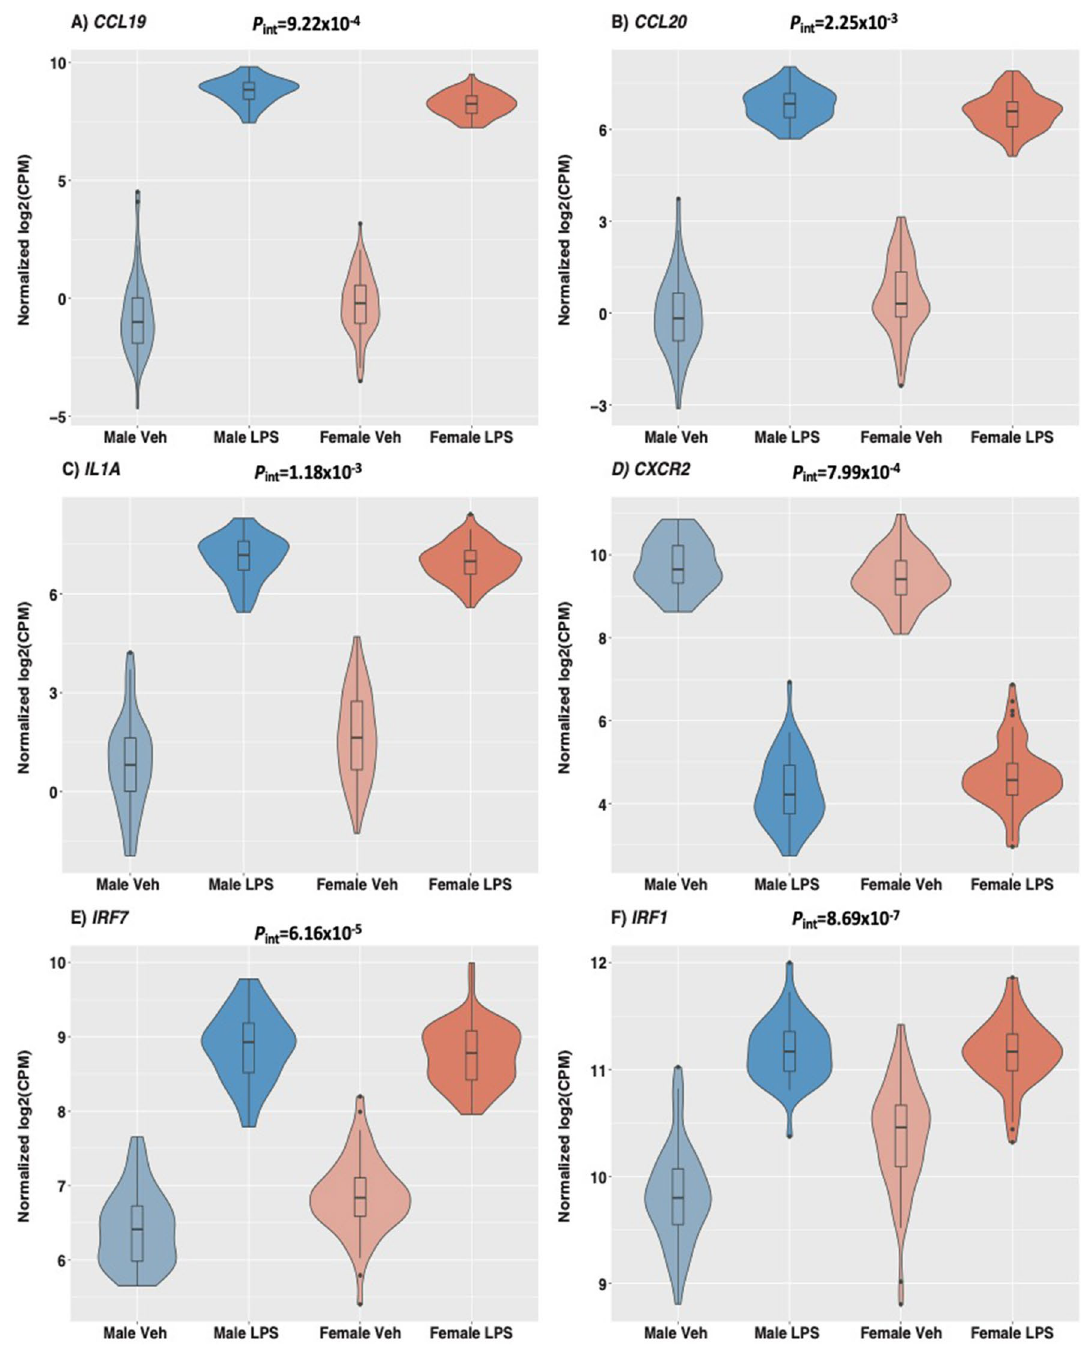
Figure 2. Violin plots of exemplar genes with significant (FDR < 0.05) LPS treatment by sex interaction effects on gene expression indicating different responses to LPS treatment in males and females. Interaction p-values are shown. For each gene, expression levels for each treatment and sex are shown on the x-axis (male untreated, male LPS-treated, female untreated, female LPS-treated). Each boxplot inside the violin shows the 1st-3rd interquartile range; the horizontal line shows the median expression value. ( A ) CCL19 , Chemokine ligand 19; ( B ) CCL20 , chemokine ligand 20/macrophage inflammatory protein-3; ( C ) IL1A , Interleukin 1 alpha; ( D ) CXCR2 , Interleukin 8 receptor, beta; ( E ) IRF7 , Interferon regulatory factor 7; ( F ) IRF1 , Interferon regulatory factor 1. Interaction P -values are shown. Note the different y-axis